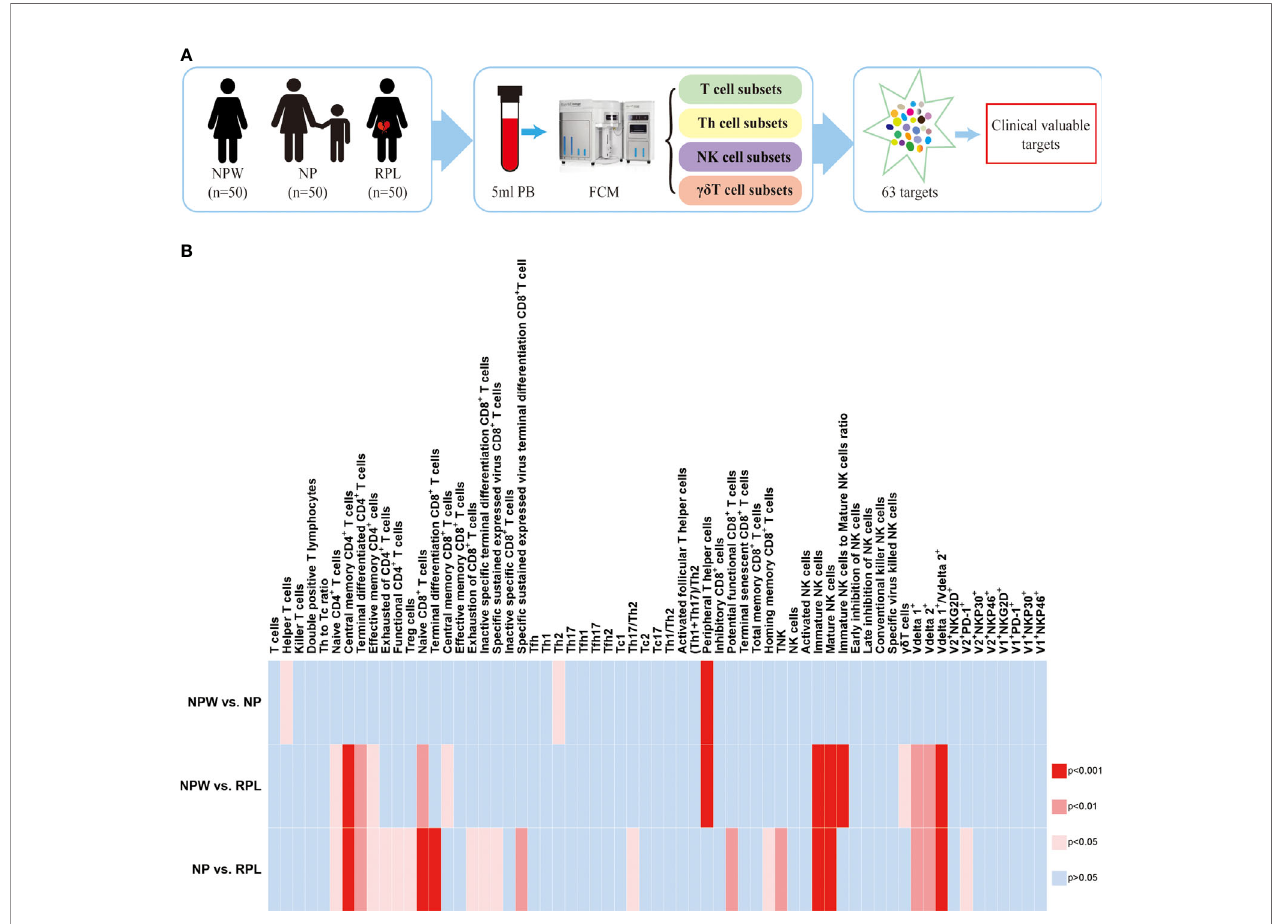
FIGURE 1 | Study design and the overview of the different immunological parameters among the three groups. (A) Schedule of the study. Three groups were included in our study: NPW group (women who were never pregnant, n=50), NP group (women with the history of normal pregnancy, n=50) and RPL group (women with the history of RPL, n=50). Peripheral blood mononuclear cells (PBMCs) were isolated from 5 ml peripheral blood. Total 63 immune cell subsets were simultaneously detected by fl ow cytometry, including T cell, NK cell and gd T cell subsets. By analyzing the data, clinical-relevant immune parameters were fi nally identi fi ed. (B) Heat map of the signi fi cantly changed immune parameters. The 63 immunological parameters were compared among the three groups and presented as the heat map, which can directly show the differences. The colors represent the different signi fi cance among the comparisons. The deeper the color is red, the larger the differences are. The blue represents no signi fi cance. NPW, women never pregnant; NP, women with a history of normal pregnancy; RPL, women with ahistory of